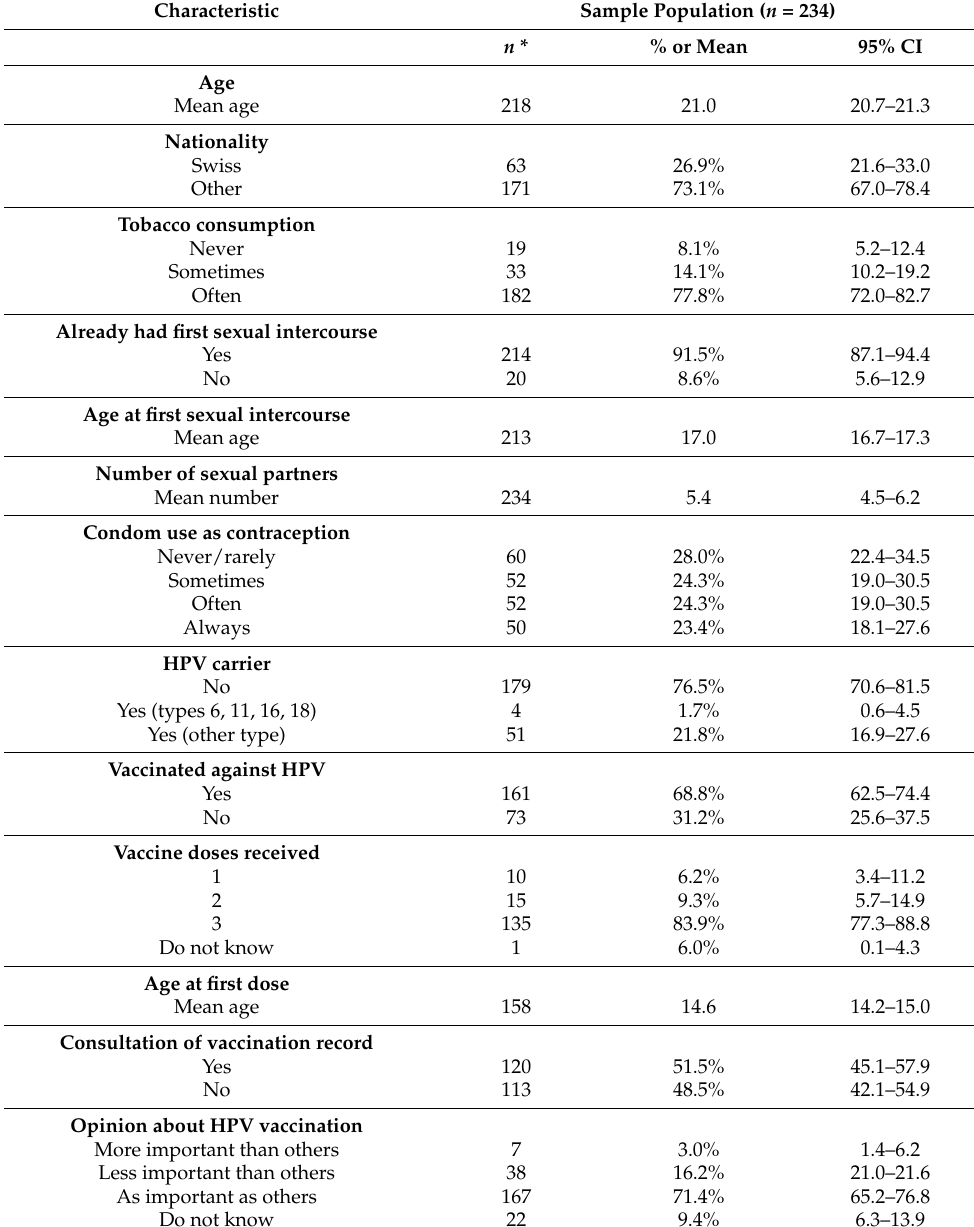
Table 1. Sociodemographic